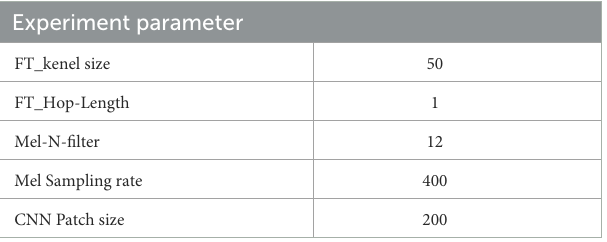
TABLE 6 Table of optimal experimental parameters for the LogMel-CRNN model proposed in this paper. Experiment parameter